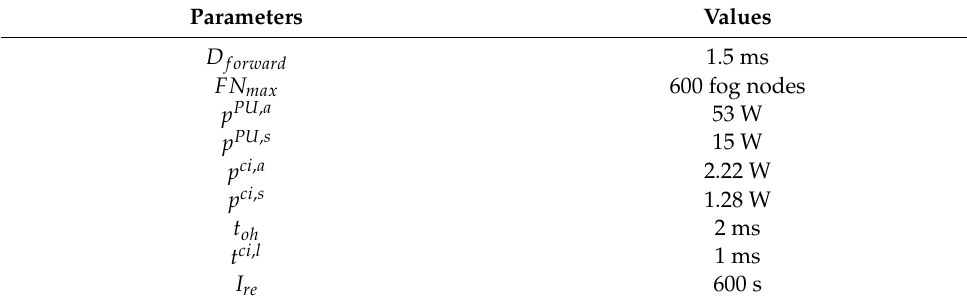
Table 1. Parameters used in performance